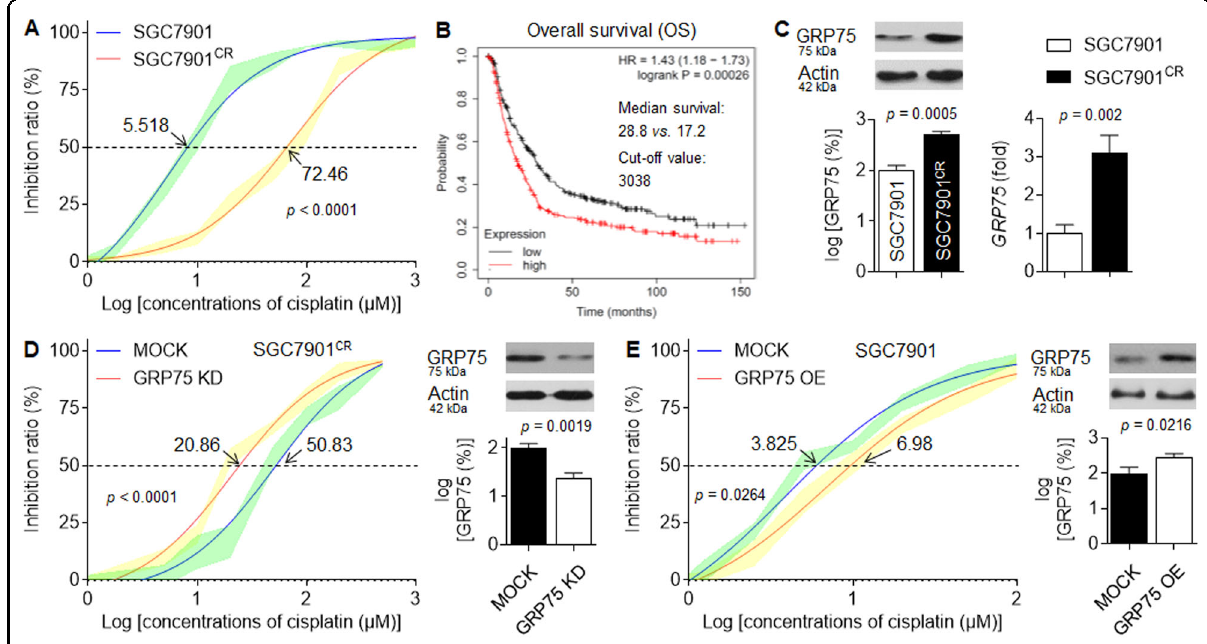
Fig. 1 Effects of GRP75 on cisplatin-resistance in GC. A SGC7901 or SGC7901 CR cells were treated by different concentrations of cisplatin (0 to 10 3 μ M) for 24 h, respectively. The cell viabilities were determined in triplicate, and the IC fi cance of GRP75 [Affy ID: 50 s were calculated. B Prognostic signi 200691_s_at (HSPA9), http://kmplot.com/analysis/index.php?p = service&cancer = gastric]. C Western blot analysis and qPCR analysis in triplicate of the levels of GRP75 protein (left) and mRNA (right). D and E SGC7901 CR cells were transfected by scrambled or GRP75 siRNA, while SGC7901 cells were transfected by scrambled or GRP75 plasmids. Cells were treated with different concentrations of cisplatin for 24 h. The cell viabilities were determined in triplicate, and the IC50s were calculated. Western blot analysis of the GRP75 in GC